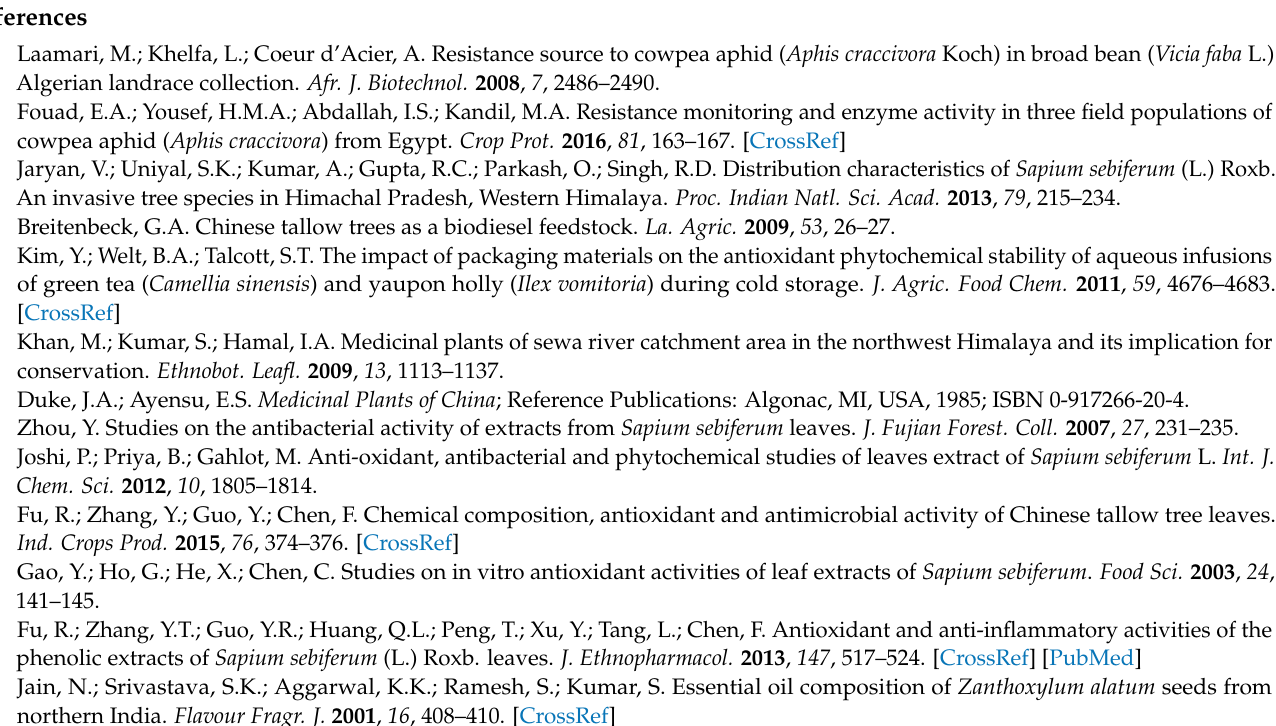
quercetin-3- O -glucoside. Figure S6: 1 H NMR spectrum of quercetin-3- O -glucoside. Figure S7: 13 C NMR spectrum of quercetin-3- O -glucoside. Figure S8: ESI-MS of gallic acid. Figure S9: 1 H NMR spectrum of gallic acid. Figure S10: 13 C NMR spectrum of gallic acid. Table S2: Observed data and reported data of gallic acid and shikimic acid from Triadica sebifera . Figure S11: ESI-MS of shikimic acid. Figure S12: 1 H NMR spectrum of shikimic acid. Figure S13: 13 C NMR spectrum of shikimic acid. Table S3: Synergistic activity of leaf/bark extracts and SO of Triadica sebifera against Aphis craccivora (72 h). Table S4: Synergistic activity of leaf/bark extracts and SO of Triadica sebifera against Aphis craccivora (96 h). Table S5: Efficacy of leaf/bark ethanolic aqueous extracts and SO of Triadica sebifera against Aphis craccivora under plant growth chamber. Figure S14: Bio-efficacy of compounds isolated from leaf fractions of Triadica sebifera against Aphis craccivora